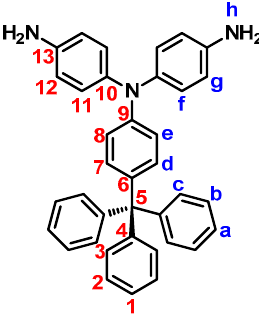
Figure 3. Structure and codes of hydrogen atoms of compound 3 .